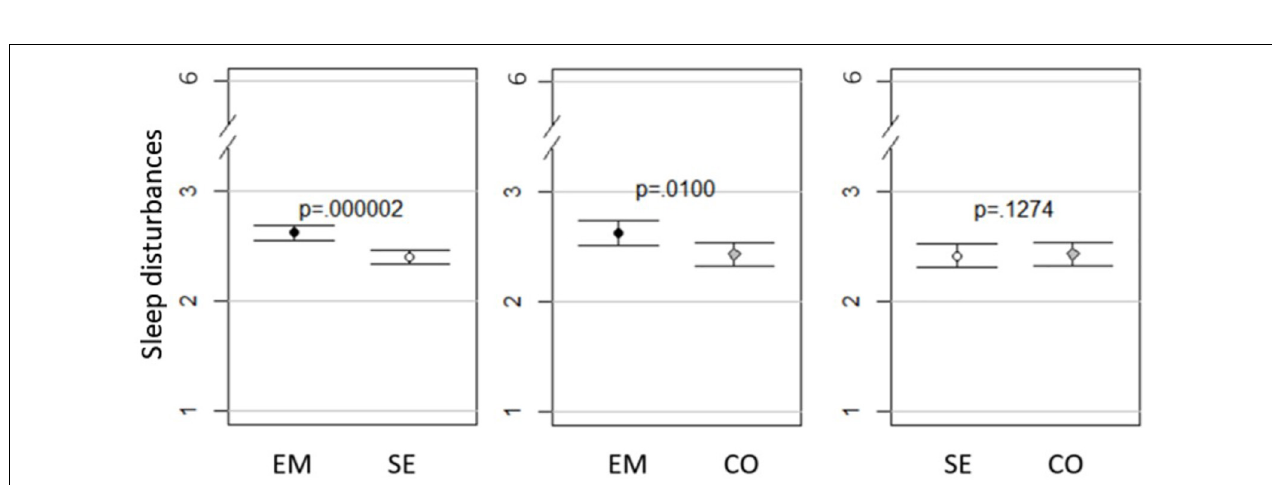
FIGURE 3 | Mean sleep disturbances with 95% Cl and p -values in employed (EM), self-employed workers (SE), and combinators